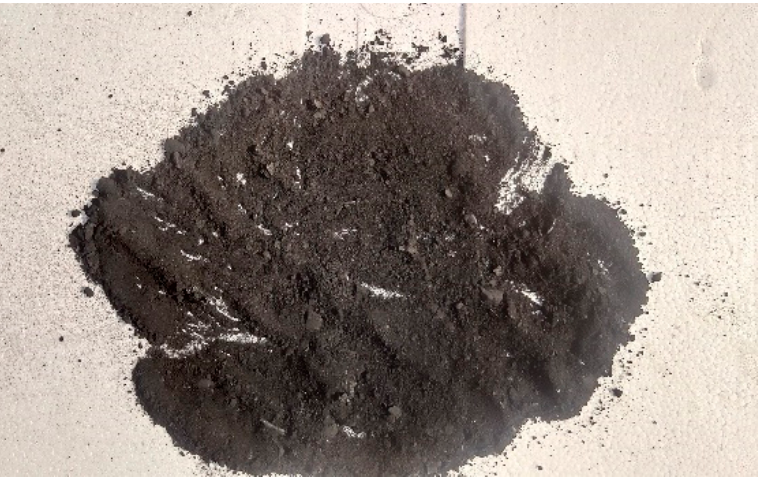
Figure 10. 90 phr of CB powder formed in the mixing process.